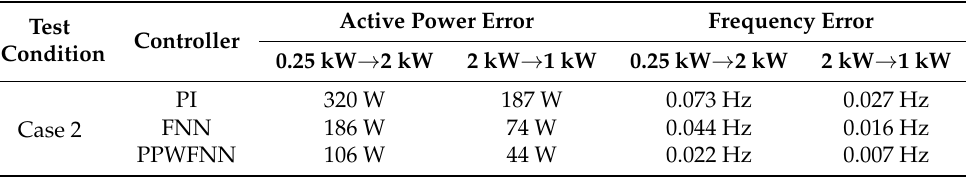
Figure 11. PPWFNN-controlled BESS using proposed virtual inertia estimator. ( a ) Responses of real power output P and reactive power output Q of BESS; ( b ) responses of line-to-line voltage v and output current i oa of BESS; ( c ) responses of virtual rotor frequency f sm of VSG control and estimated virtual inertia J s . Table 1. Maximum real power error and frequency error of PI-, FNN- and proposed PPWFNN- controlled BESSs using proposed virtual inertia estimator under load variation.